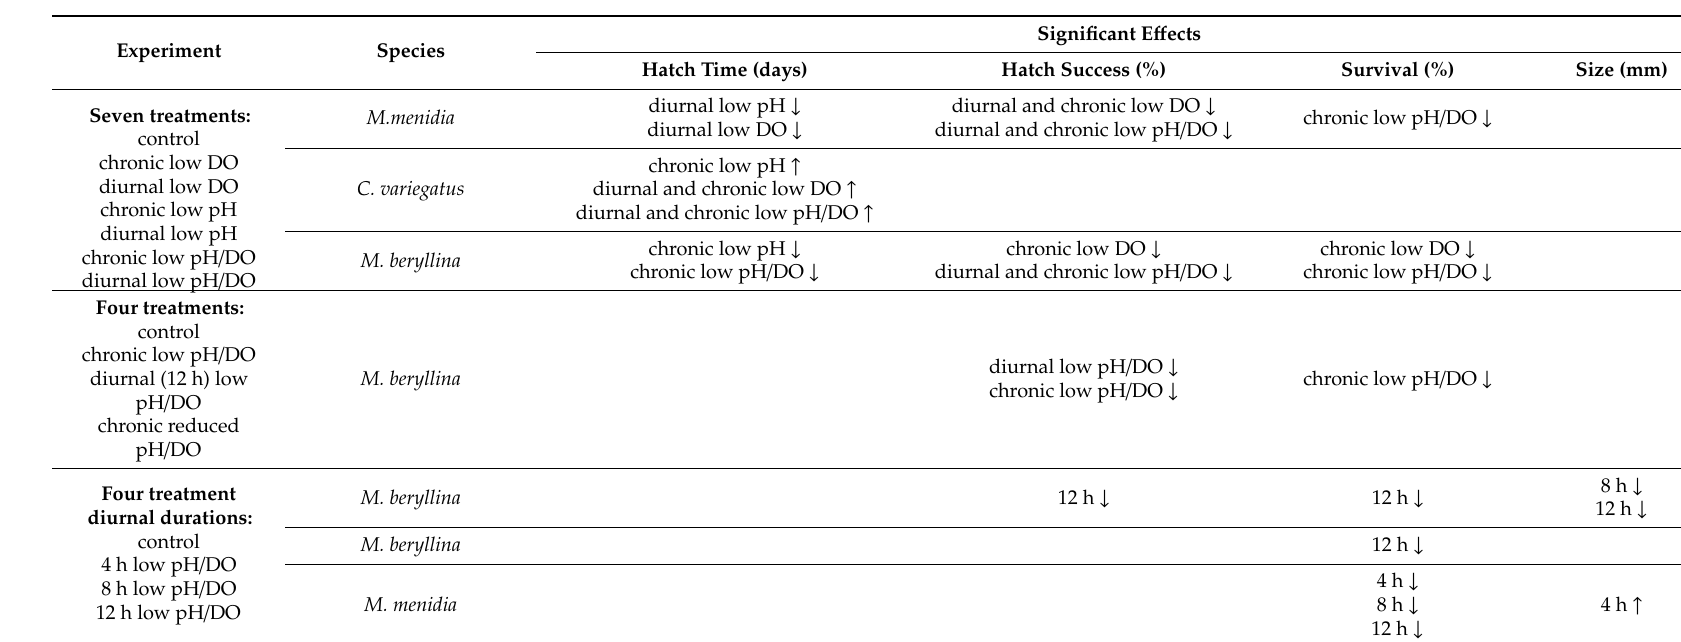
Table 1. Summary of experiments with treatments, species used, and statistically significant e ff ects; downward arrows indicate a corresponding reduction and upward arrows an increase of the measured response metric